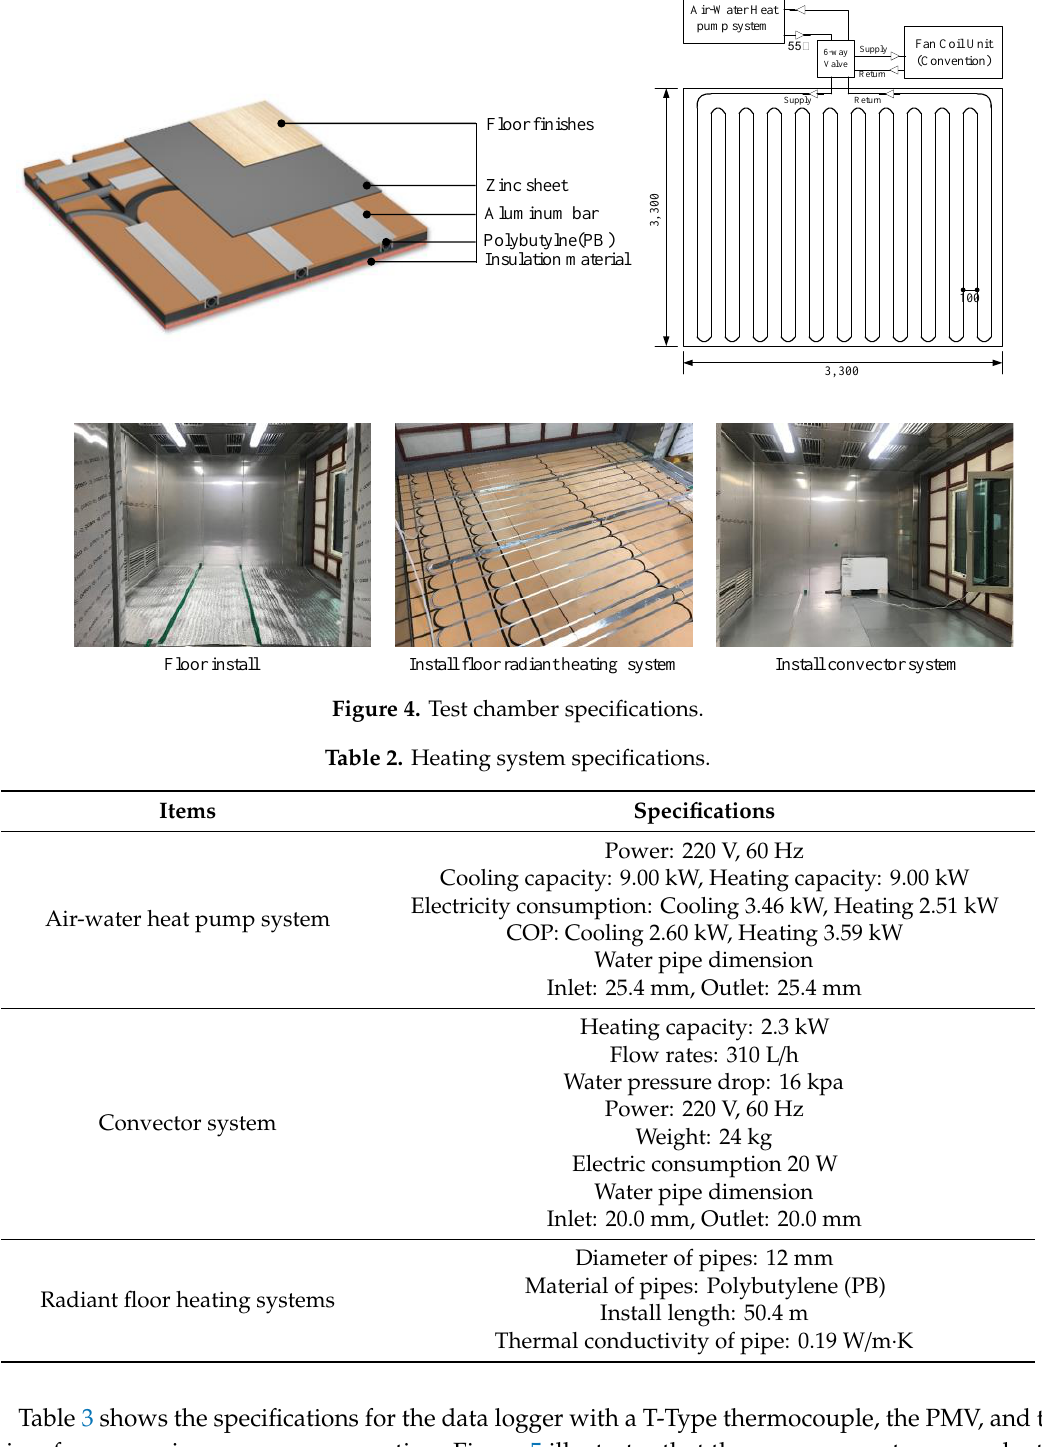
Table 3. Measuring instruments and measurement ranges.